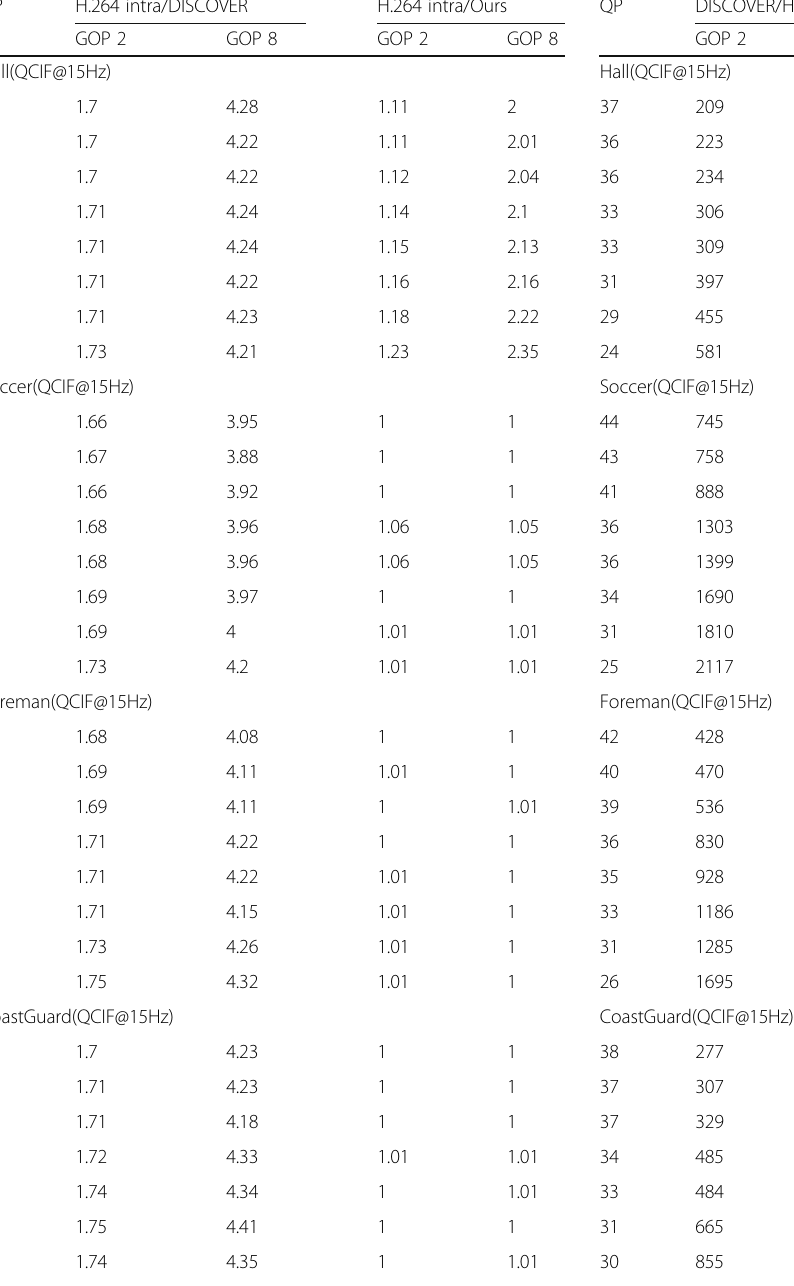
Table 2 The decoder time ratio of the proposed PB-based LVC and DISCOVER